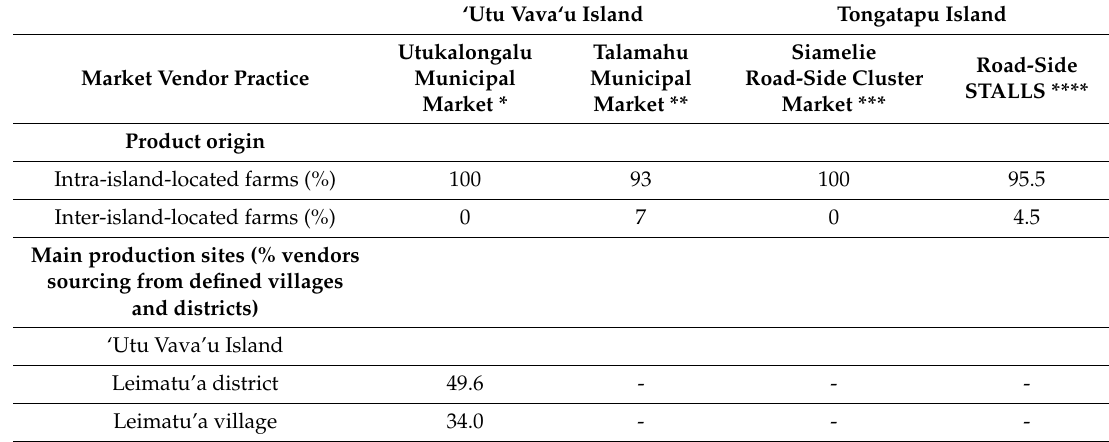
Table 1. The horticultural production centres supplying Tonga’s fruit fresh and vegetable markets, associated transport logistics, and market vendor